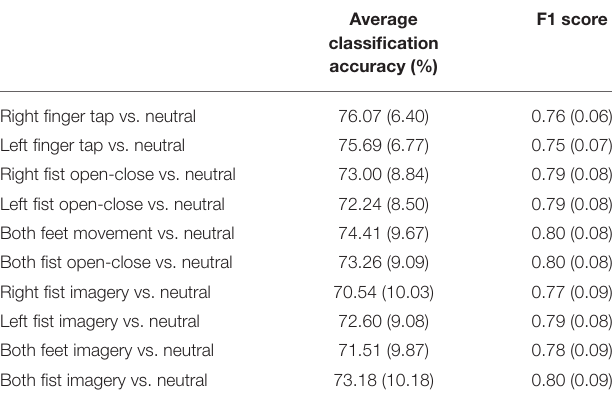
TABLE 1 | The grand average of peak linear discriminant analysis (LDA) classification accuracies for different motor tasks vs. resting state of all